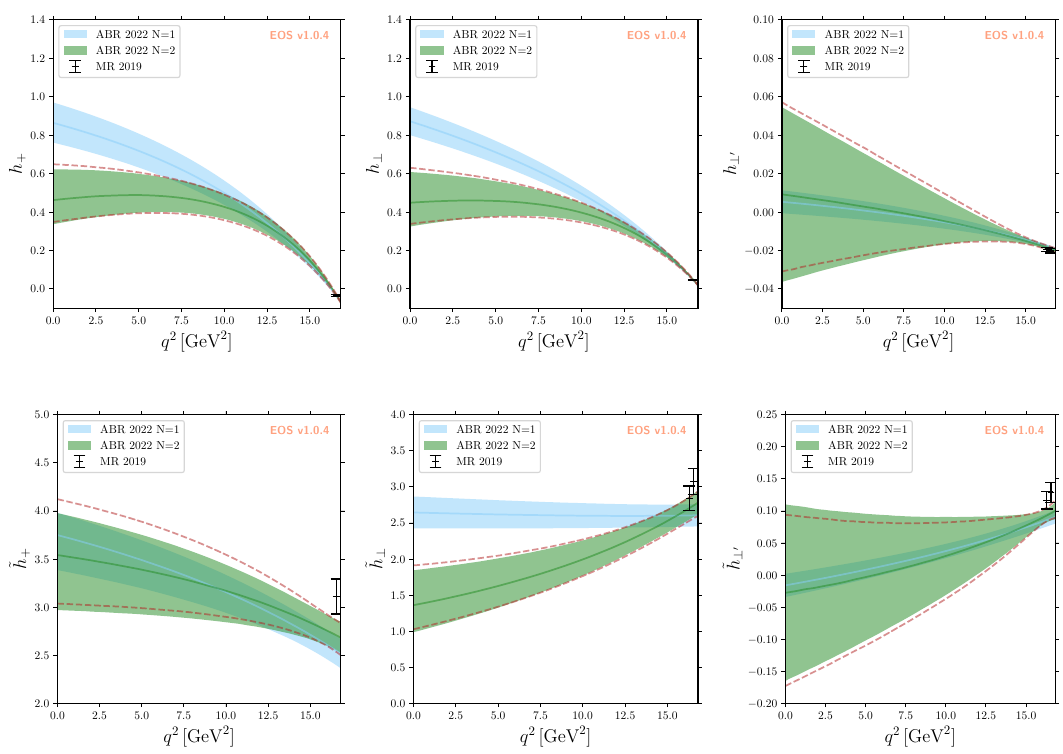
Figure 3 . Fit results for the tensor and pseudo-tensor Λ b → Λ(1520) form factors. The blue and green bands are the 68% C.L. region, and the solid line shows the median of the distribution for N = 1 and N = 2 , respectively. The dashed red lines contain the 68% C.L. region for the N = 3